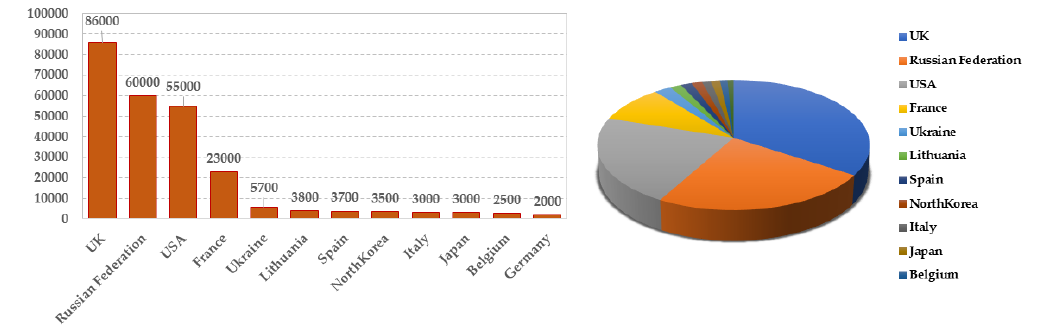
Figure 1. World resources of irradiated graphite waste by country (tons).